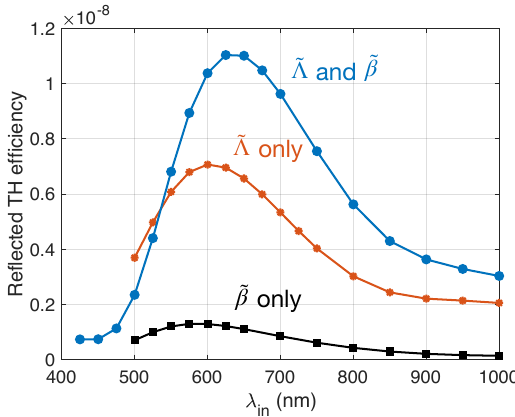
Fig. 5. Predictions of the reflected TH efficiency as a function of the pump wavelength obtained under three different scenarios: taking only bound electrons into account (black), takin only hot electrons into account (red), and taking both bound and hot electrons into account